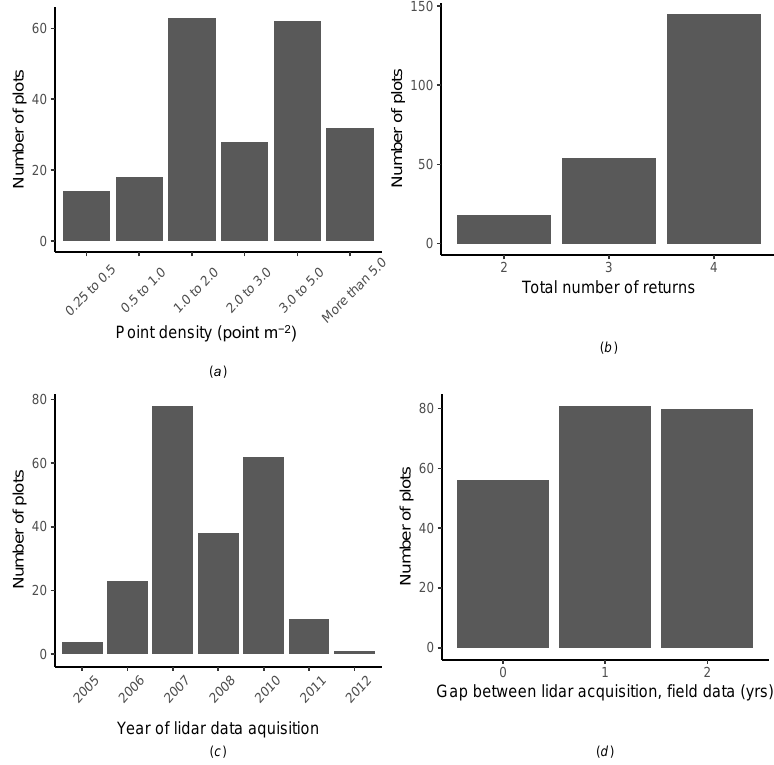
Figure 3. The distribution of some notable ALS acquisition parameters over the selected FIA plots. ( a ) Point density. The actual value calculated on the plot is shown here, which may be significantly different from the ALS project’s documented nominal point spacing based value. The median point density is 2.6 pts m − 2 . ( b ) Total number of returns labeled. For example, “1” means that the acquisition was based on a single-return system. ( c ) Year of ALS data acquisition. ( d ) Gap (in years) between the ALS data acquisition and FIA field measurement (absolute value). Around 37% of plots had a measurement lag within ± 1